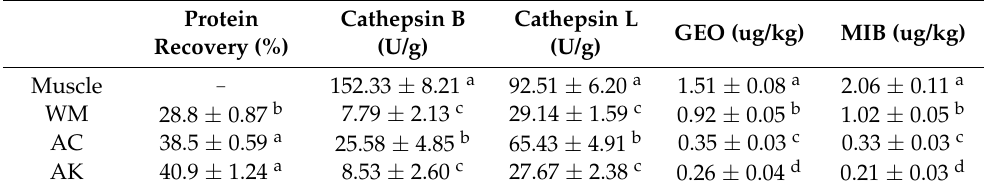
Table 1. The effect of the process on the protein recovery rate and residue activity of cathepsin B and cathepsin L. Protein Cathepsin B Cathepsin L GEO (ug/kg) MIB (ug/kg) Recovery (%) (U/g) (U/g) Muscle _ 152.33 ± 8.21 a 92.51 ± 6.20 a 1.51 ± 0.08 a 2.06 ± 0.11 a WM 28.8 ± 0.87 b 7.79 ± 2.13 c 29.14 ± 1.59 c 0.92 ± 0.05 b 1.02 ± 0.05 b AC 38.5 ± 0.59 a 25.58 ± 4.85 b 65.43 ± 4.91 b 0.35 ± 0.03 c 0.33 ± 0.03 c AK 40.9 ± 1.24 a 8.53 ± 2.60 c 27.67 ± 2.38 c 0.26 ± 0.04 d 0.21 ± 0.03